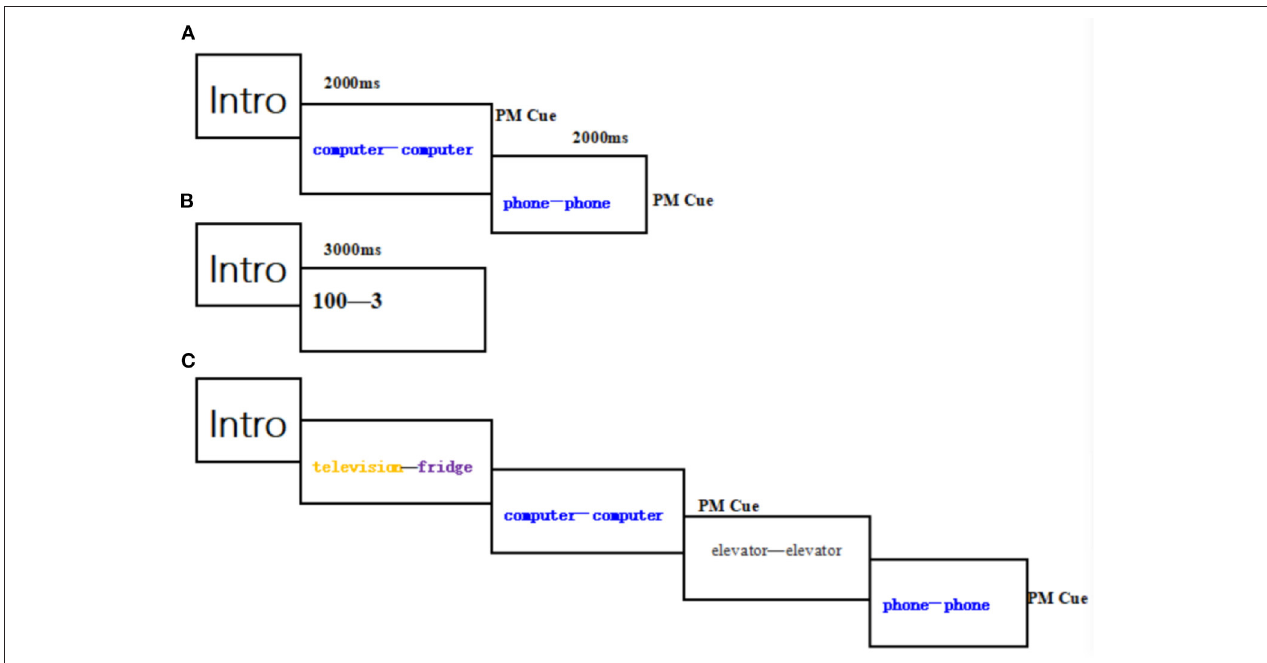
FIGURE 1 | Example block. each block consists of three stage: (A) coding stage; (B) distraction task stage; (C) ongoing task stage.